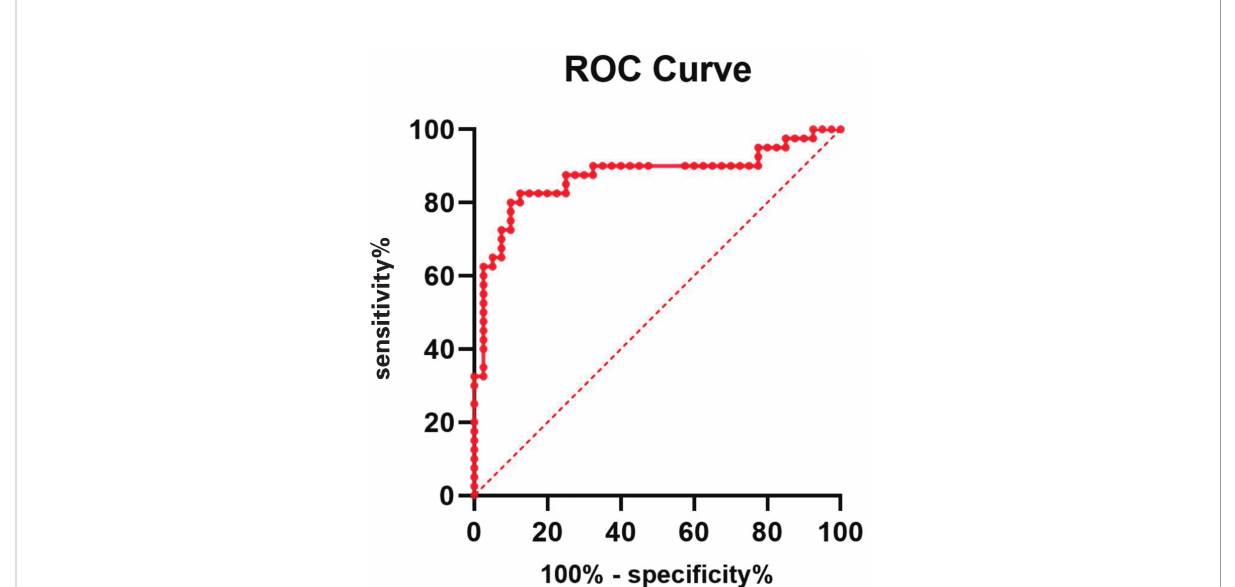
FIGURE 3 ROC curve of NSE level for PHN. The area under the ROC curve value was 0.8713 (95% con fi dence interval, 0.7861 – 0.9564; P <